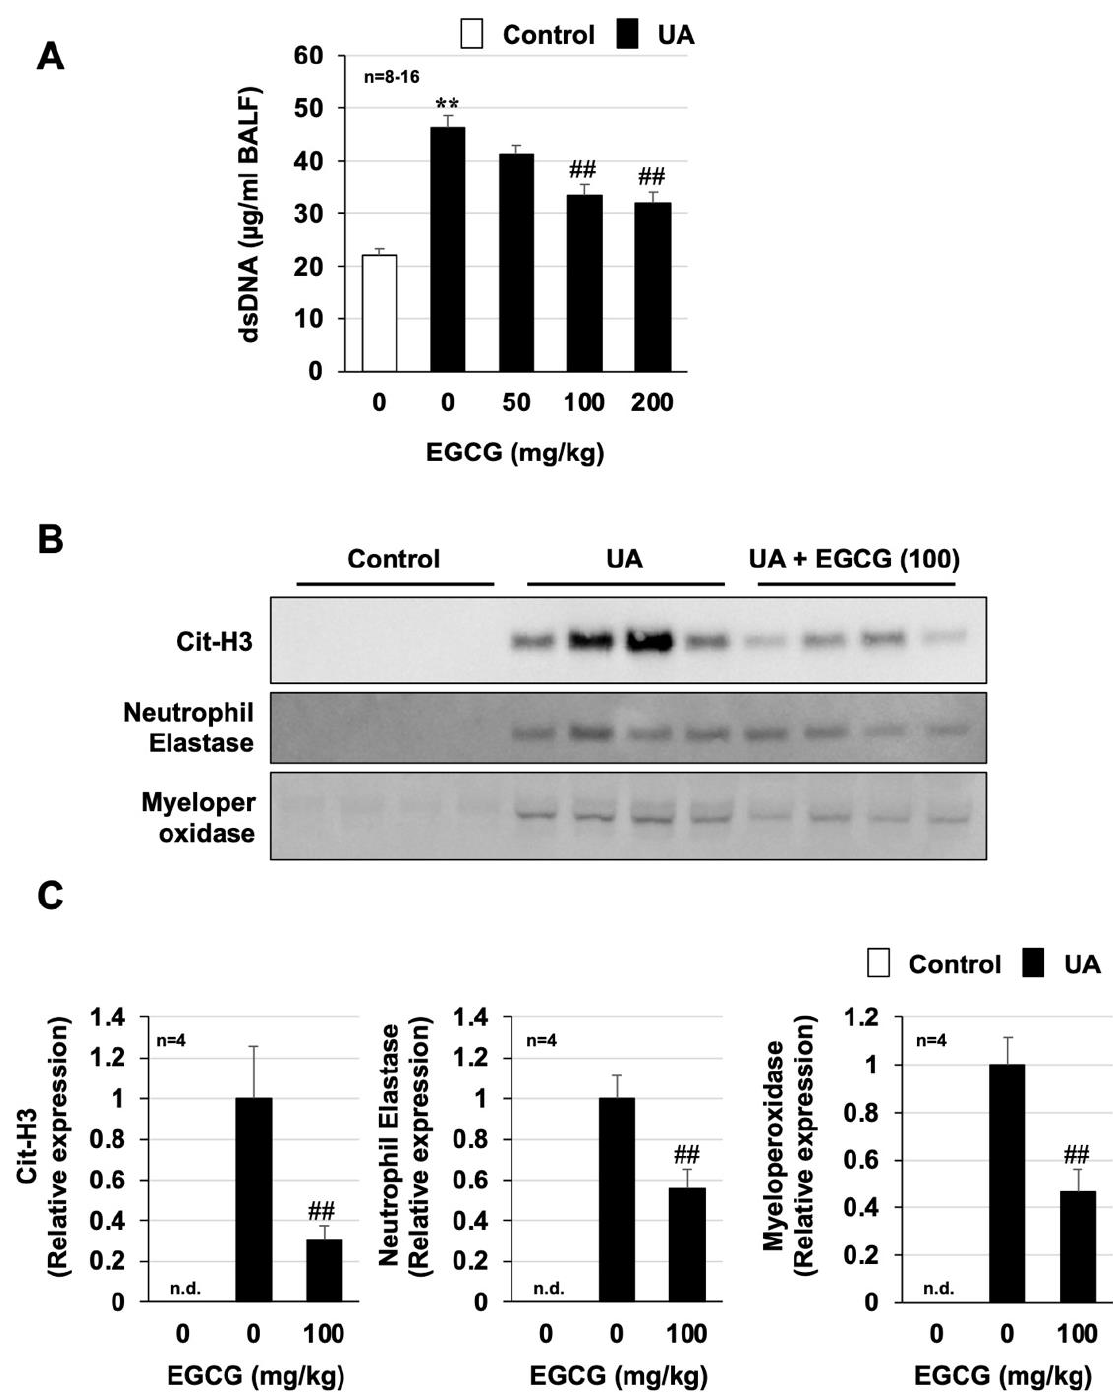
Figure 5. Effect of EGCG on urban aerosol-induced neutrophil extracellular trap formation . Male ICR mice were intraperitoneally administered EGCG (50–200 mg/kg in sterile saline) or sterile saline 1 h before intratracheal administration of urban aerosol particle suspension (1.0 mg/mouse) or sterile saline (Control). BALFs were prepared 24 h after the intratracheal administration. ( A ) The amount of double-stranded DNA (dsDNA) present in the BALF was determined using a NanoDrop Lite. ( B ) BALF samples (10 µ L) were analyzed by immunoblotting with antibodies against Cit-H3, neutrophil elastase, and myeloperoxidase. ( C ) The intensities of the bands were determined using ImageJ software. n.d. indicates not detected. Values are expressed as the mean ± SEM; ** or ## p < 0.01 ( # vs. UA).